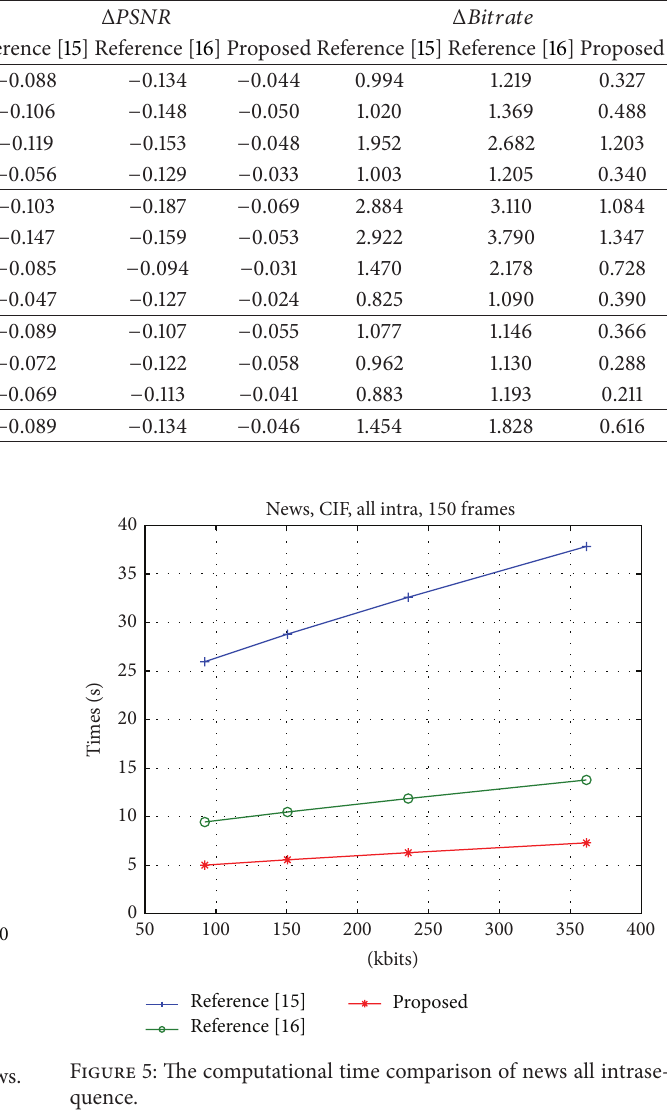
Table 2: Simulation results for all intraframes sequences.